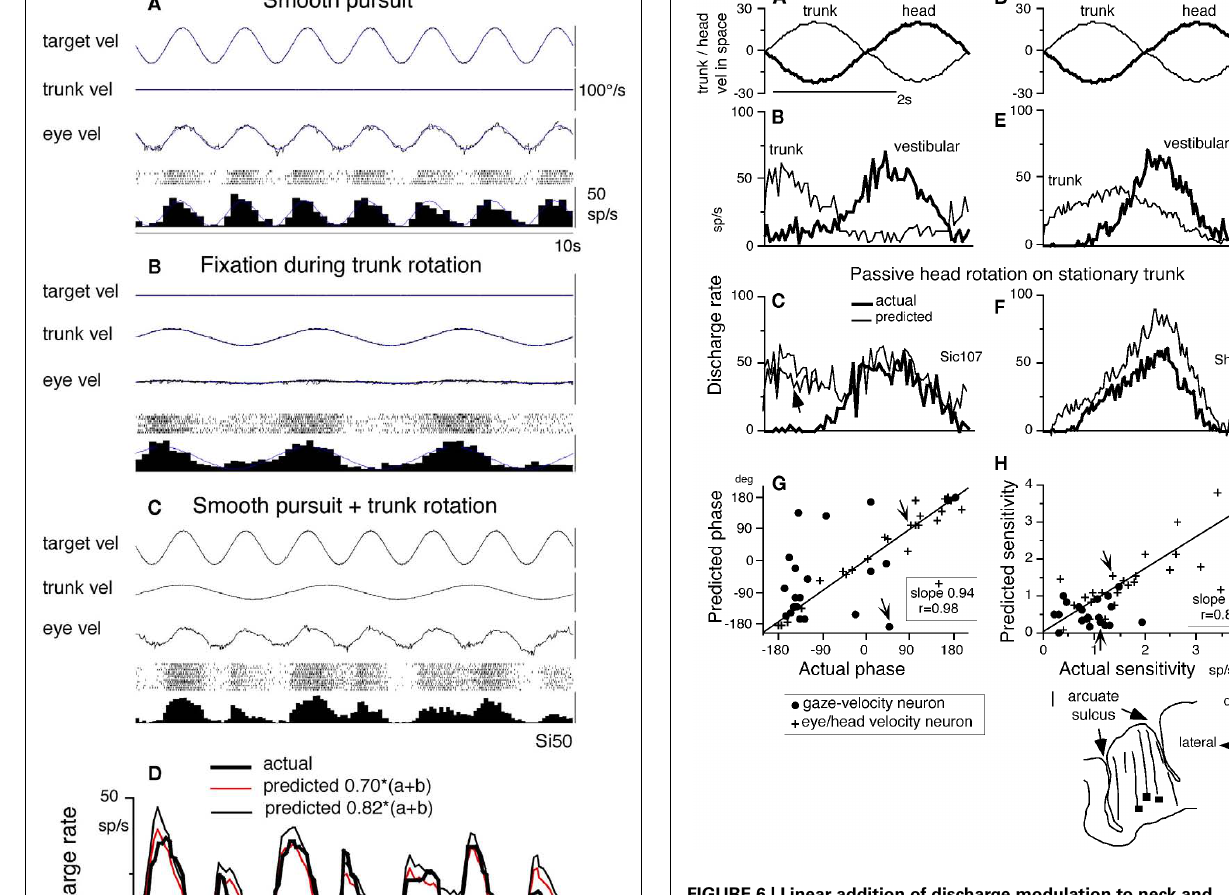
FIGURE 6 | Linear addition of discharge modulation to neck and vestibular inputs. (A , D) Stimulus velocity in space during passive trunk-on-head rotation and whole-body rotation. (B,C) and (E,F) Averaged discharge of two FEF pursuit neurons. In (A,B) and ( D,E) , passive trunk-on-head rotation (thin lines) and whole-body rotation (thick lines) were applied separately while, in each condition, the monkeys fixated a stationary spot in space. In (C,F) , passive head-on-trunk rotation was applied (thick lines, actual) while the monkeys fixated a stationary target.Thin lines in (C,F) are predicted modulation calculated by adding neck and vestibular modulation (B,E) . Directions of chair rotation during whole-body rotation (vestibular) and trunk-on-head rotation [(neck (A,D) ] are shown oppositely, since during passive head-on-trunk rotation, neck movement direction relative to the trunk is opposite to trunk movement direction induced by chair rotation (see Figures 1E,F ). Resting discharge rate was subtracted from the predicted discharge in (C,F) . In (G,H) , phase (G) and sensitivity (H) of predicted modulation (re stimulus velocity) that was calculated by adding neck and vestibular modulation are plotted against actual modulation (re stimulus velocity) during passive head-on-trunk rotation for gaze-velocity neurons and eye/head-velocity neurons. Responses of the two example neurons (A–F) are indicated by arrows in (G,H) . (I) Transverse section of representative recording tracks of monkey Si and locations of three pursuit neurons responding to trunk-on-head rotation (squares). Reproduced from Fukushima et al. (2010) with